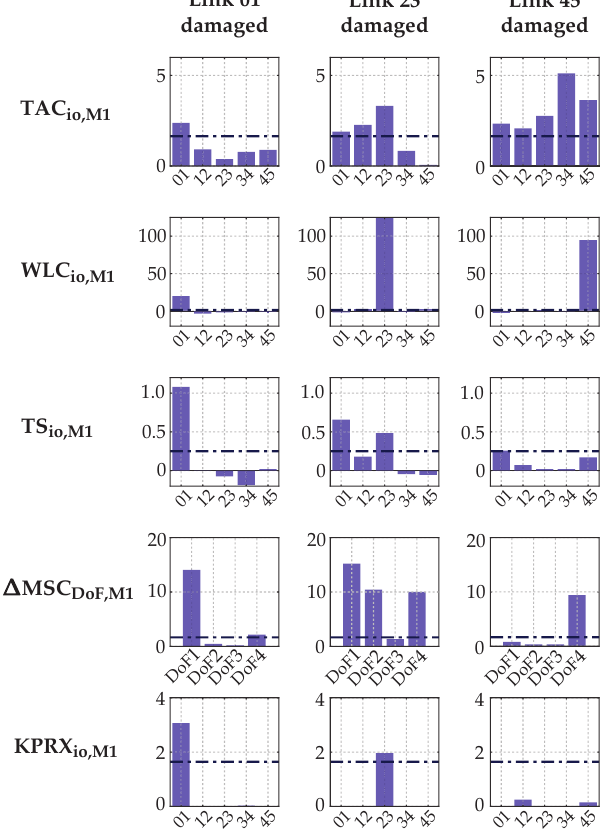
Figure 10. Local evaluation of five DSFs: TAC ( first row ), WLC ( second row ), TS ( third row ), ∆ MSC ( fourth row ), KPRX ( last row ). To accommodate the changing reference distributions, the values are represented using the Mahalonobis distance from the healthy reference distribution. Results are reported for one earthquake instance simulated on a model with nonlinearity limited to the link 01 ( left ), link 23 ( center ), and link 45 ( right